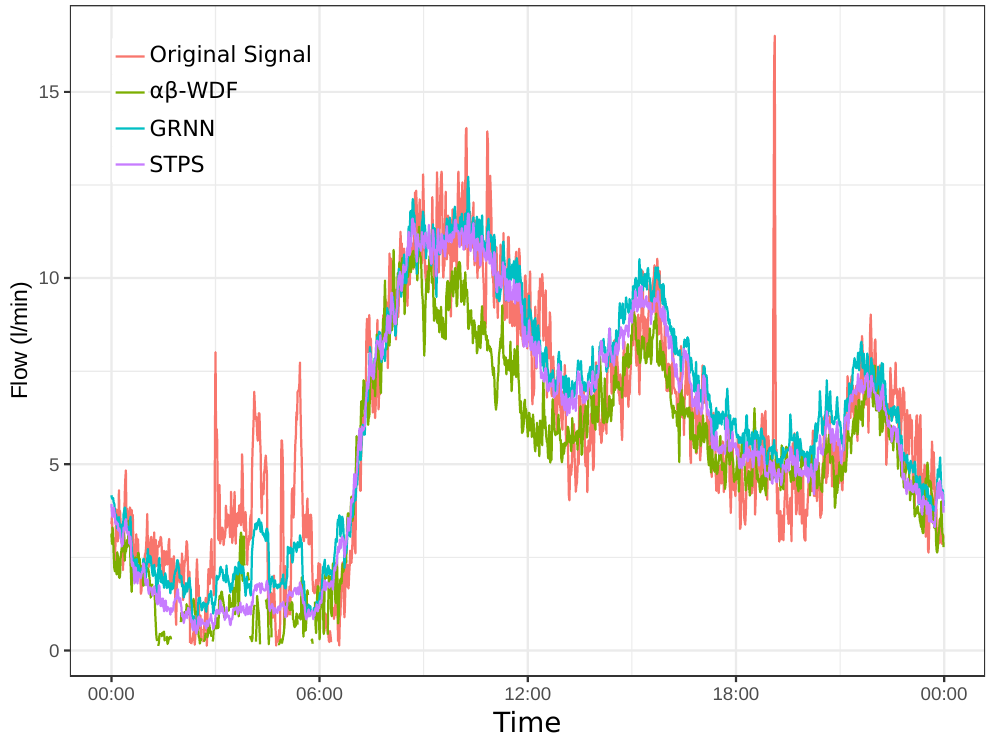
Figure 9. Forecasting for the downtown site for Wednesday, 1 June 2015. The red line denotes the measured values, the green line the predicted values by the αβ -WDF (Water Demand Forecast) approach, the blue line the prediction of GRNN (Generalized Regression Neural Network), and the violet line the predicted values by our approach (STPS, Short-Term Pattern Similarity).